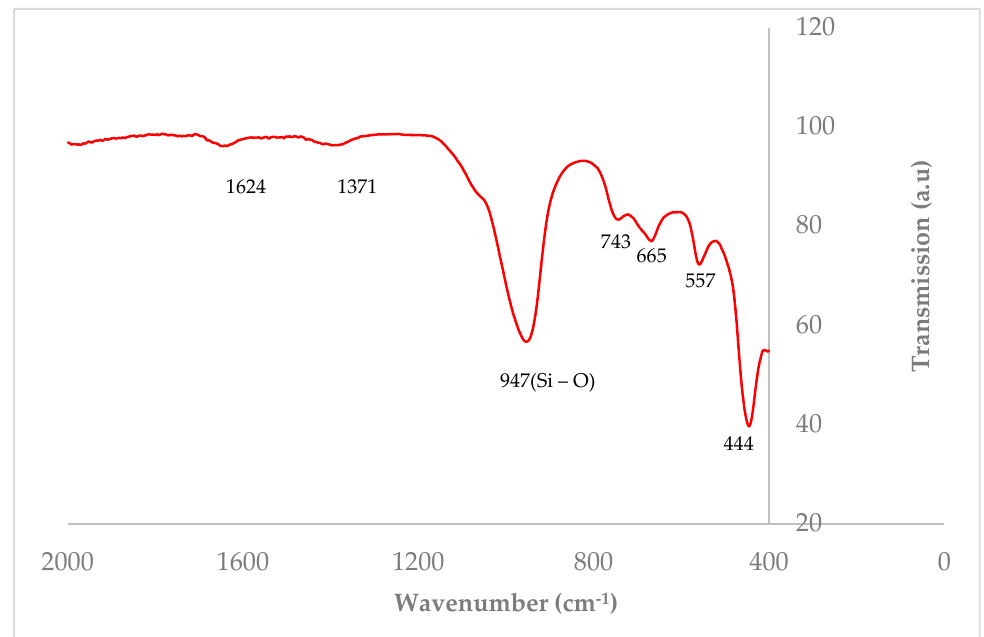
Figure 4. Spectrum obtained for Fourier-transformed infrared spectrometry (FT-IR) analysis of synthesized zeolite Y sample.